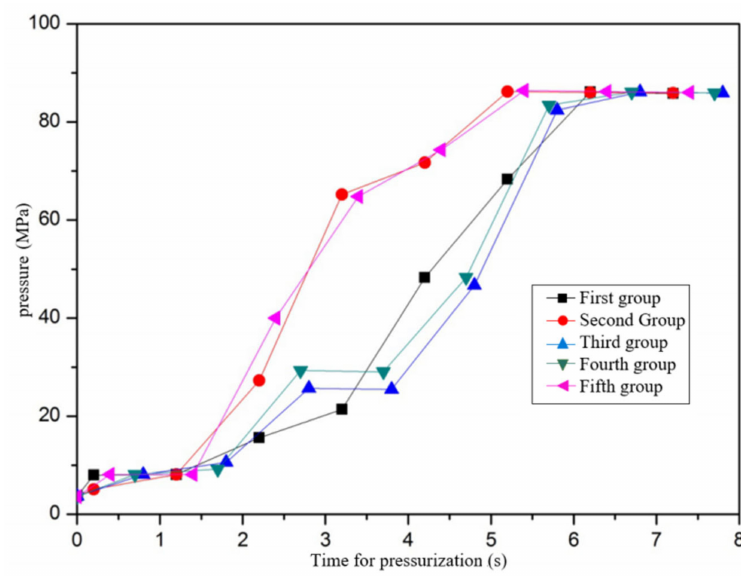
Figure 21. Pressure time curve of two hose assemblies.